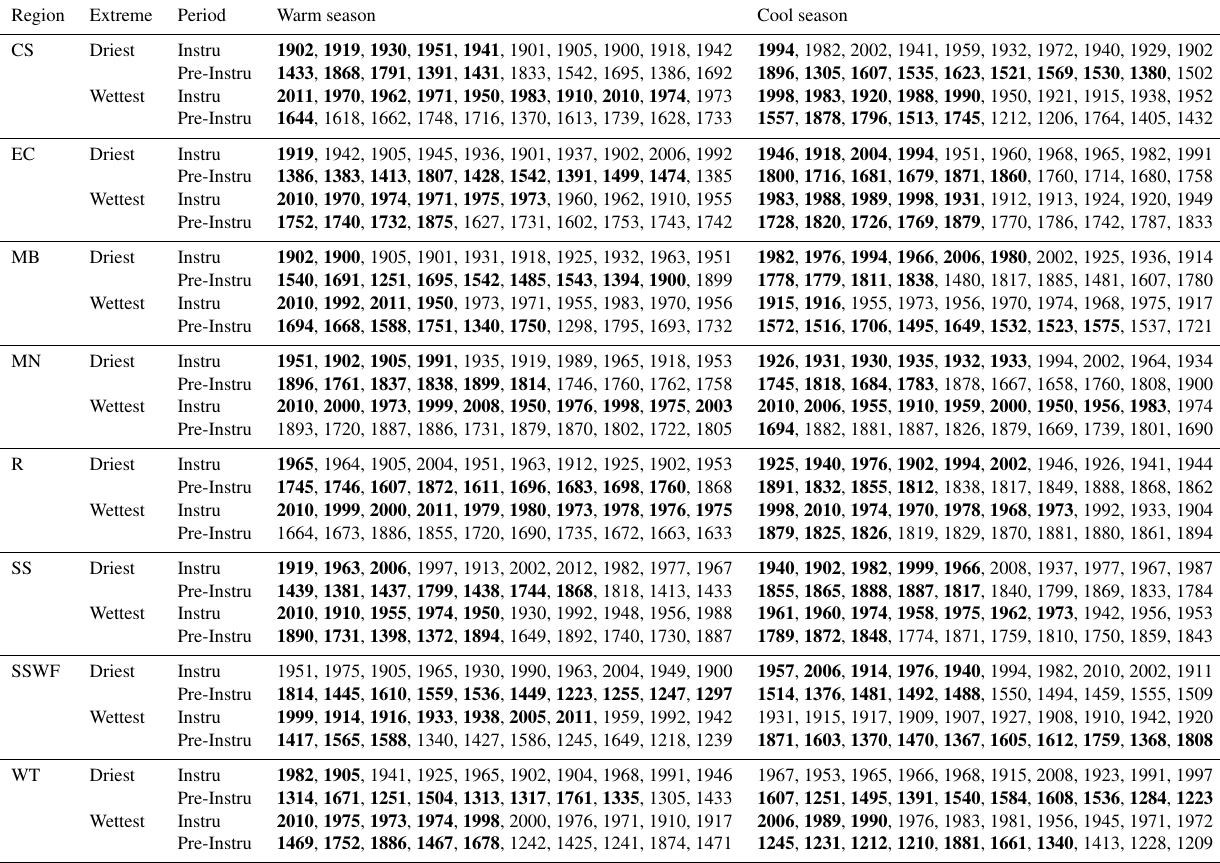
Table 2. Extreme years. Summary of the 10 driest and wettest seasons for each NRM region for different baselines. Different baselines refer to the instrumental period (Instru: 1900–2014) and the extended reconstruction period (Pre-Instru: 1200–2014). Years highlighted in bold are among the 10 highest/lowest values for the entire reconstruction and instrumental period and therefore referred as extreme. Note the reconstruction period starts for verified periods only and differs for regions and